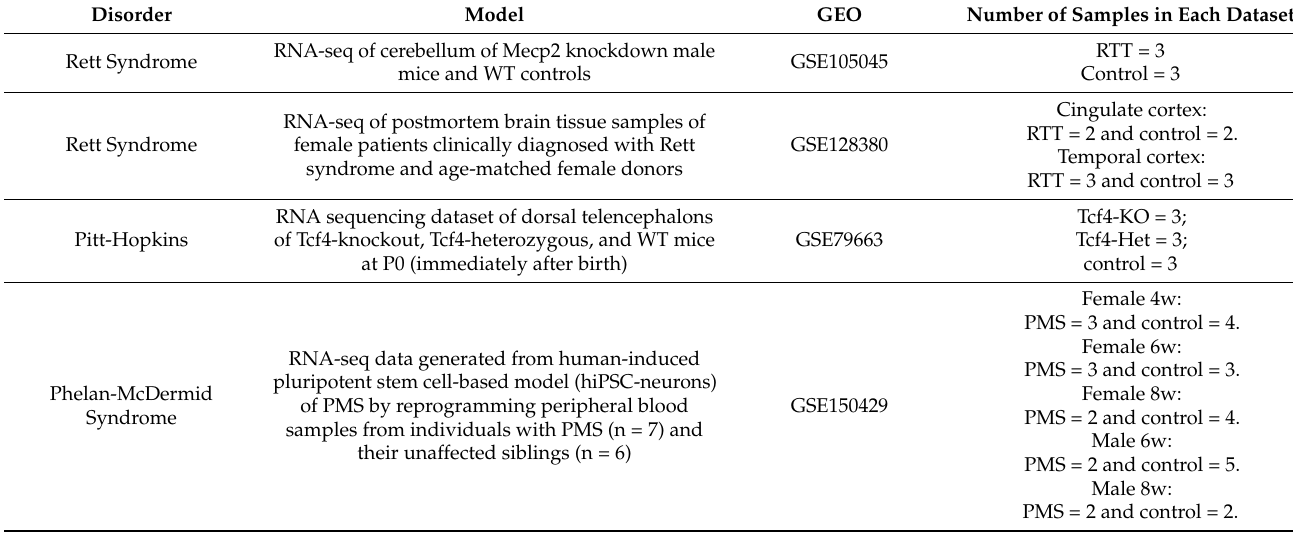
Table 1. Data sets downloaded from NCBI for